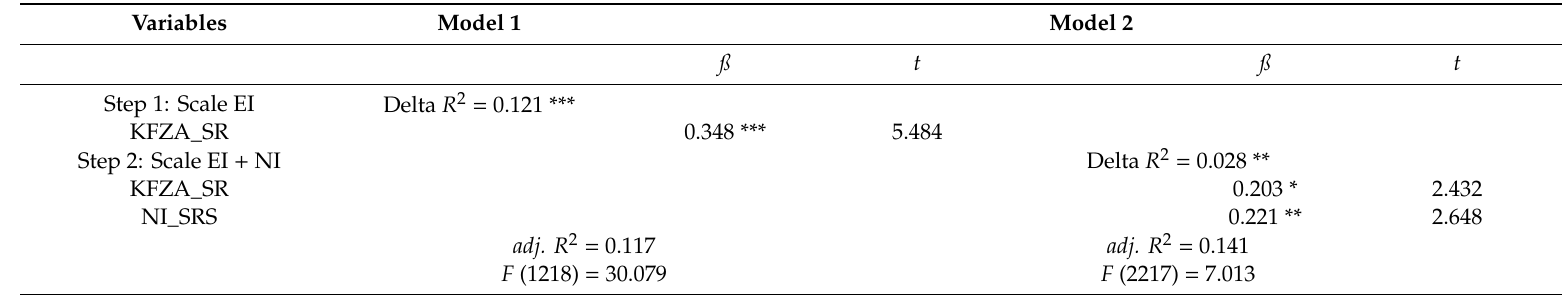
Table A4. Hierarchical regression analyses for the relation between well-being and scales from existing instruments (EI) and the new instrument (NI) assessing social relations (with supervisors).